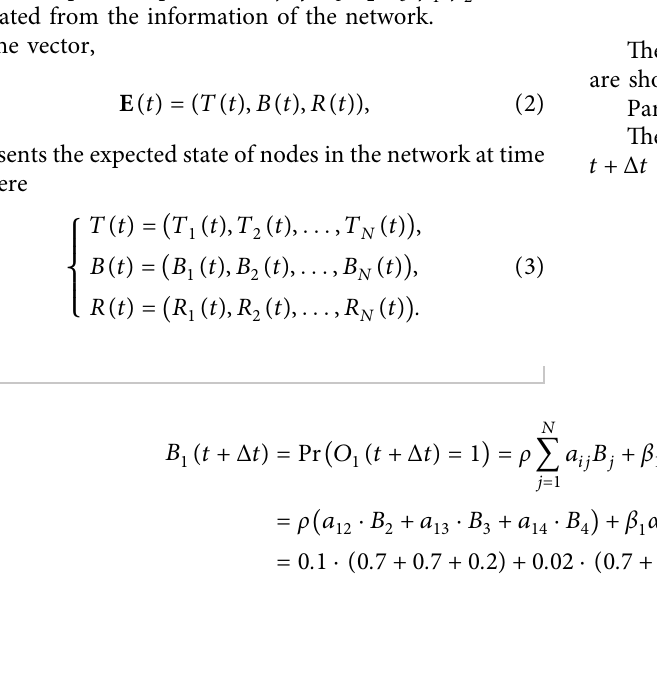
, α , α , β , β can be 1 2 3 1 2